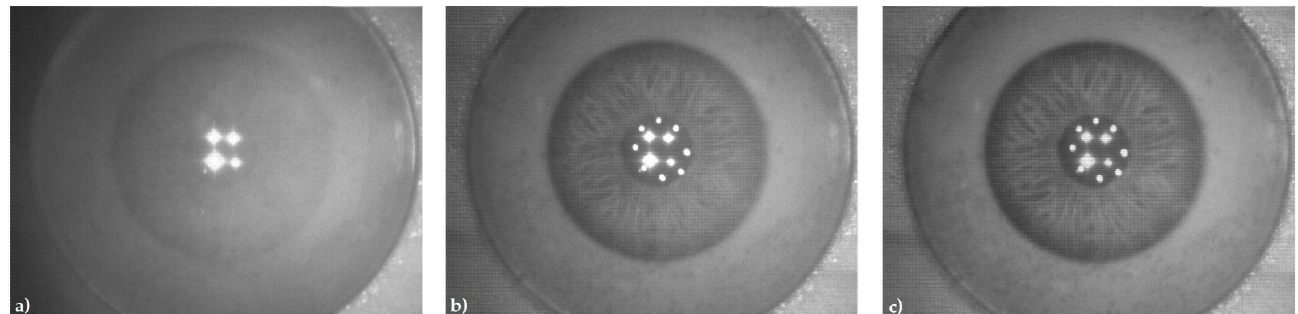
Figure 14. Acquired 8 bit grayscale images of the artificial eye at distance 100 mm, at a focus lens position of 590 digits,